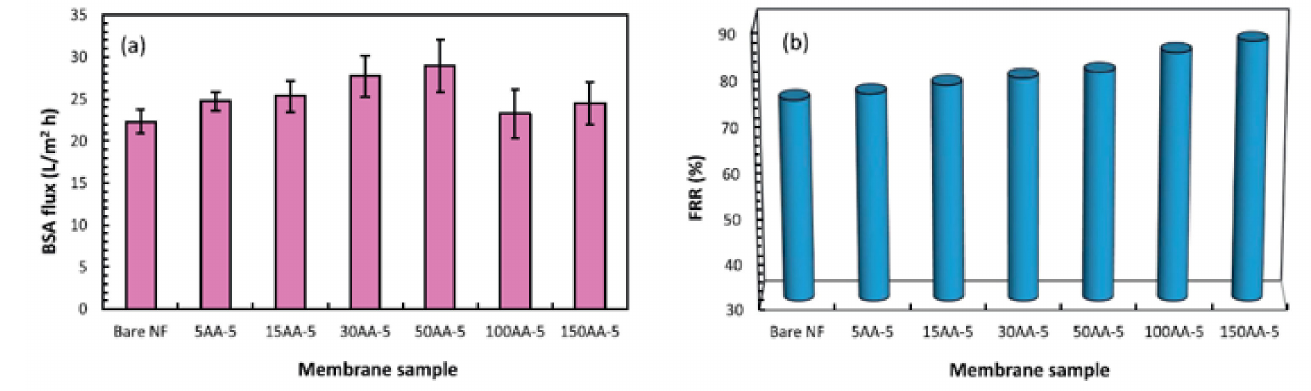
Figure 14. ( a ) BSA flux; ( b ) FRR of the AA-grafted NF membranes with various AA concentrations